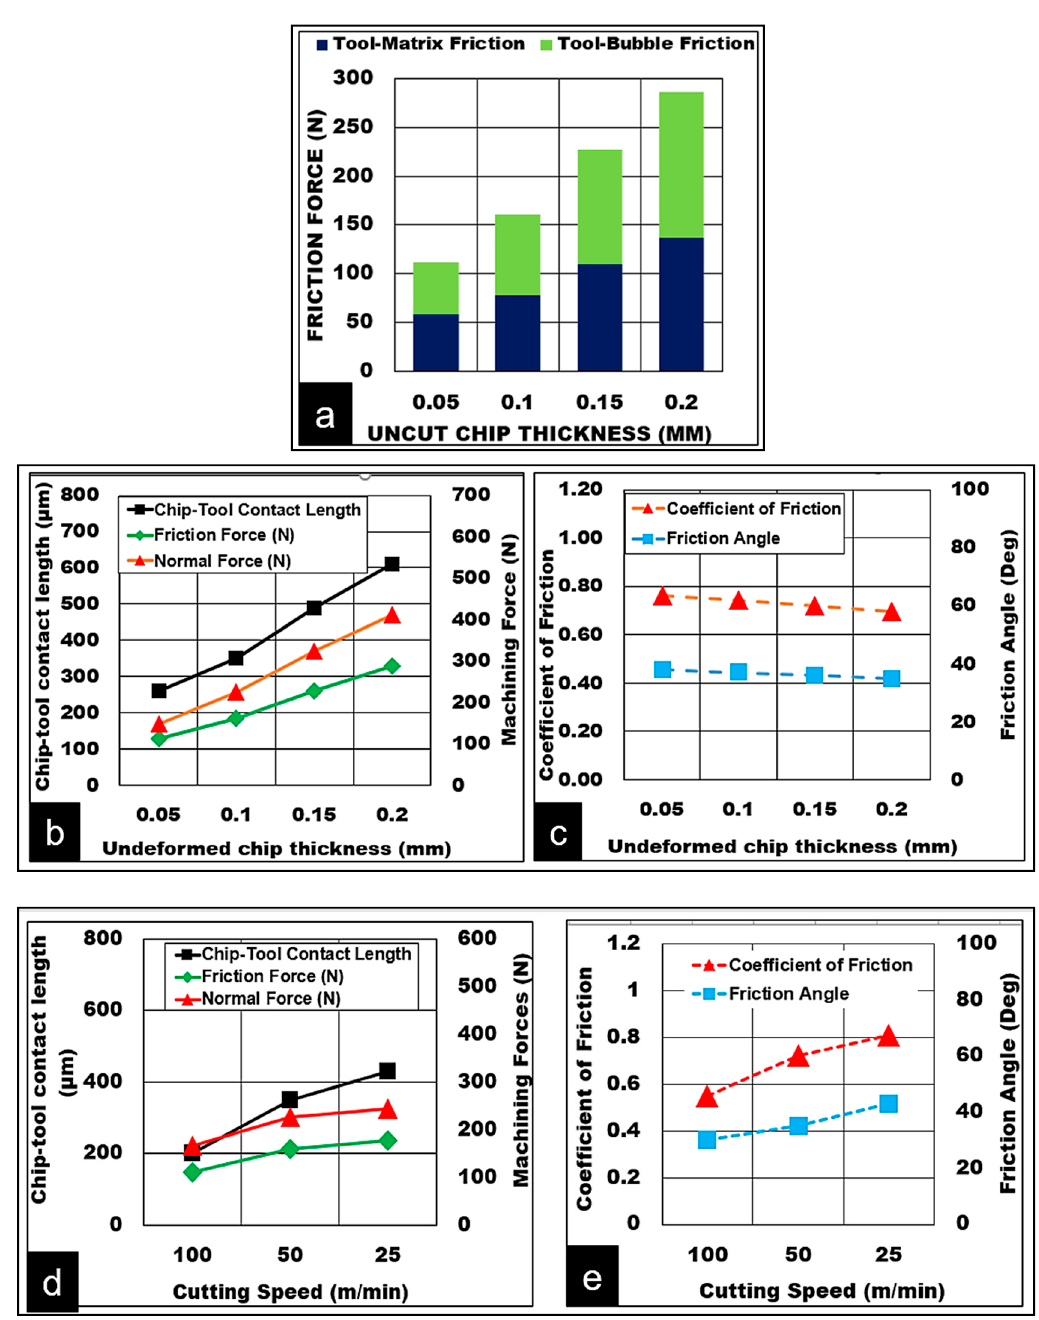
Figure 5. Relationship between various AZ31 foam cutting parameters ( a ) Friction due to the matrix and microballoon abrasion with increasing uncut chip thickness ( b ) and ( c ) Effect of uncut chip thickness on tool-chip contact length and friction coefficient ( d ) and ( e ) Effect of cutting speed on tool-chip contact length and friction coefficient, (Bubble volume fraction = 15%, b = 3 mm, Dry cut).